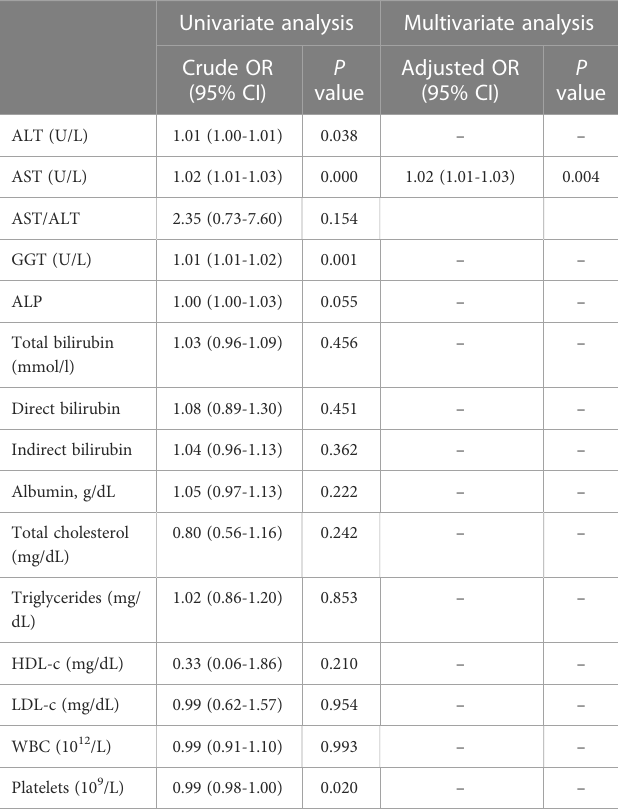
OR, odds ratio; CI, con fi dence interval. BMI, body mass index; WHR, waist to hip ratio; T2D, type 2 diabetes; FPG, fasting plasma glucose; HbA1c, glycated hemoglobin; HOMA-IR, Homeostatic model assessment of insulin resistance; BUN, blood urea nitrogen; SUA, serum uric acid; ALT, aminotransferase; AST, aspartate aminotransferase; GGT, g -glutamyl transpeptidase; ALP, alkaline phosphatase; HDL-C, high-density lipoprotein cholesterol; LDL- C, low-density lipoprotein cholesterol; WBC, white blood cells. #Per 0.1 increase